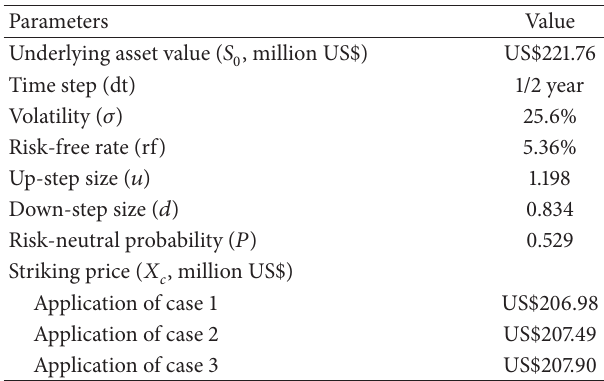
Table 3: Parameters to estimate the value of governmental guaran-